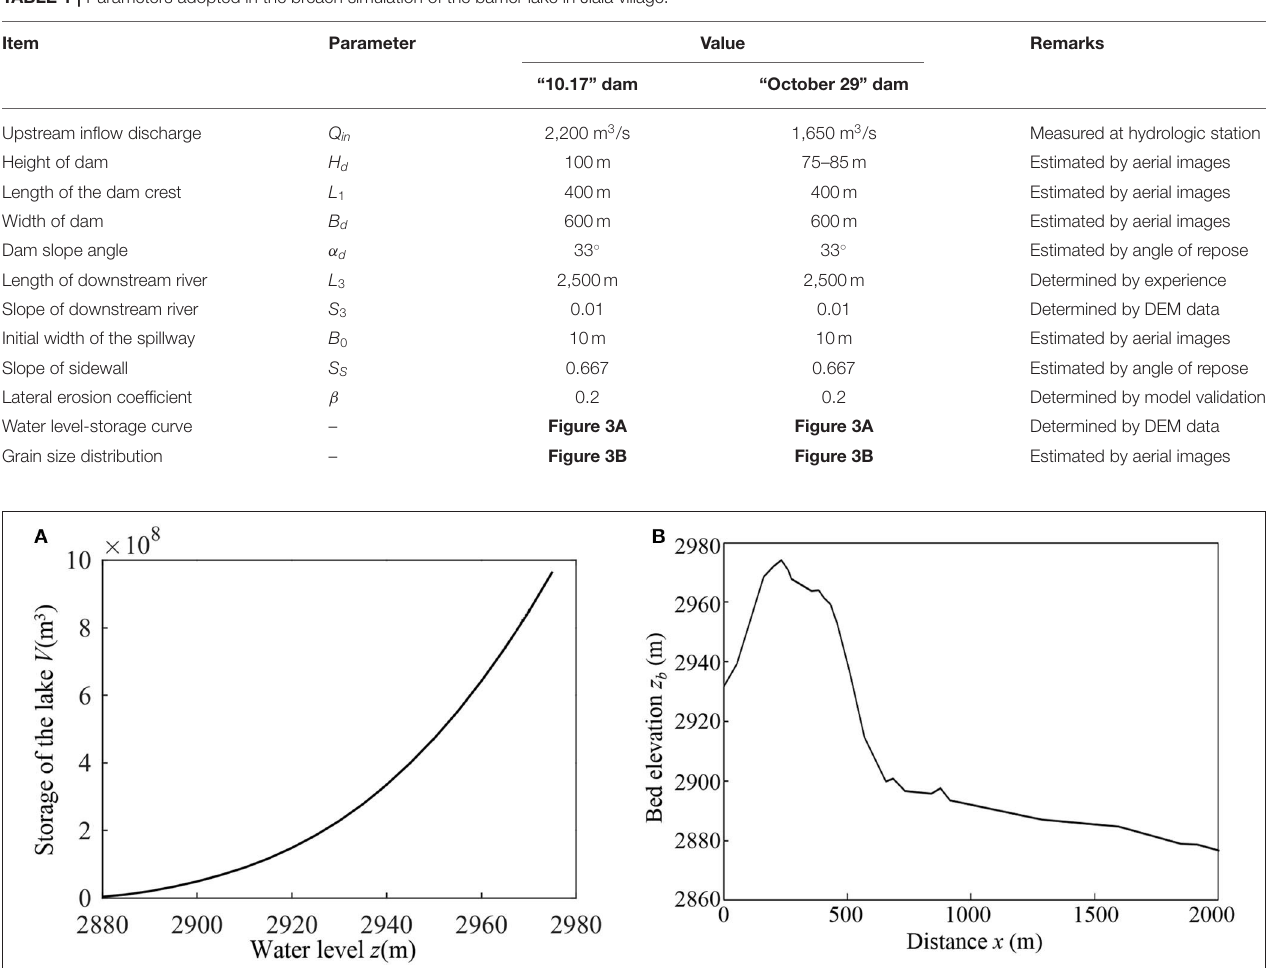
FIGURE 4 | Calculation conditions for the breach simulation of the Baige barrier lake. (A) The level-storage curve of the Baige barrier lake; (B) the longitudinal profile of the “November 3” Baige landslide dam (measured by SBSMG and